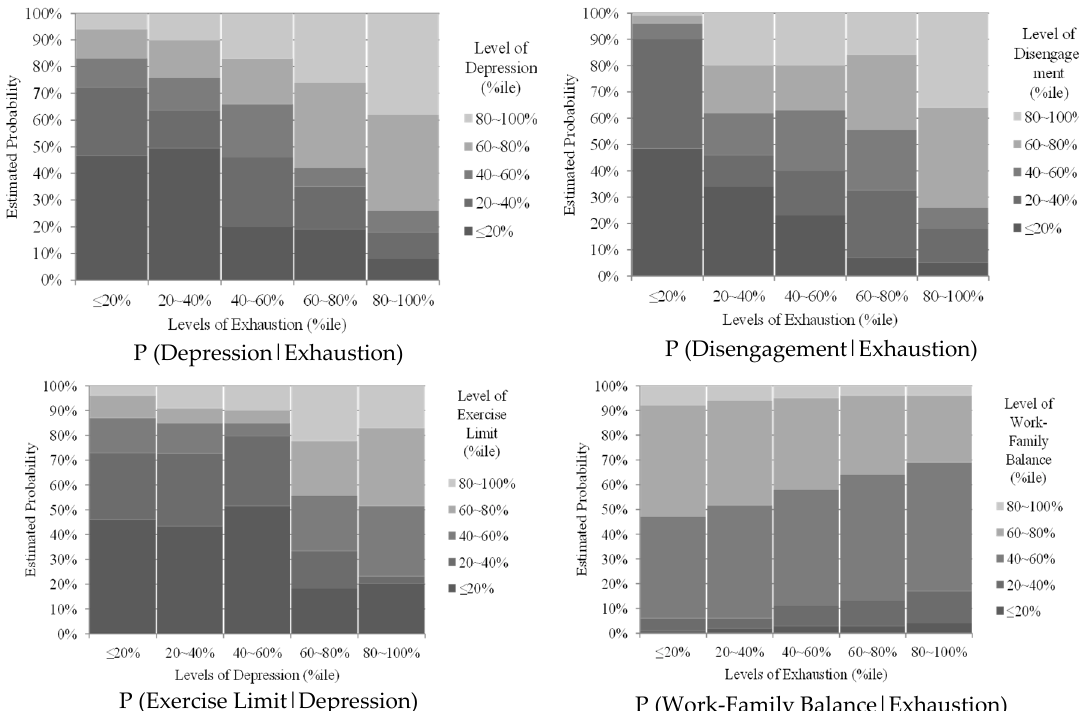
Figure 2. Conditional probability distribution based on the data-driven final Bayesian Network model. Notes: P(Y|X) = conditional probability of Y given X (i.e., probability of a particular state of Y